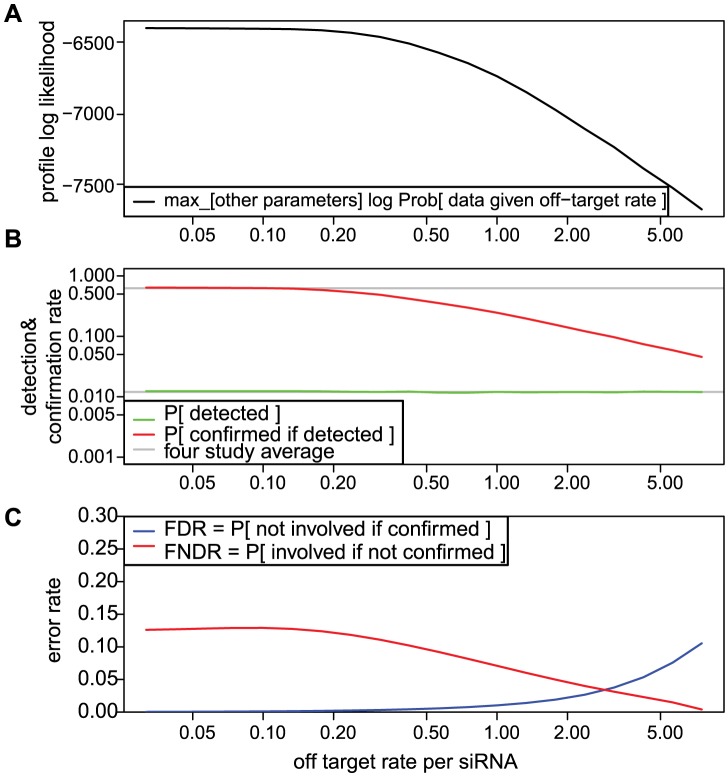
Likelihood estimation prefers a small off-target rate.Maximum likelihood estimates (MLEs) are parameter settings that provide the best explanation for observed multi-study agreement counts, yet the estimate for ν, the mean number of off-targets per siRNA, is surprisingly small (Table 4). Profile likelihood provides additional insight into this effect. At each fixed ν on a fine grid we found MLEs of the remaining system parameters as well as the maximum (log) likelihood (Panel A). The decreasing profile likelihood re-expresses the inference that fit decays if we insist on moderate to large values for ν. One reason for the poor fit is seen in a comparison of (study averaged) detection and confirmation rates computed at the profile MLEs (Panel B). Although the best fitting detection rate (green) matches the empirical detection rate regardless of ν, the best fitting confirmation rate (red) is much lower than its empirical counterpart. The profile MLE values can also be converted to false discovery rates (FDR) and false non-discovery rates (FNDR), as shown in Panel C. In the regime preferred by the observed multi-study counts (small ν), false negatives dominate, but the opposite inference follows if ν is large.